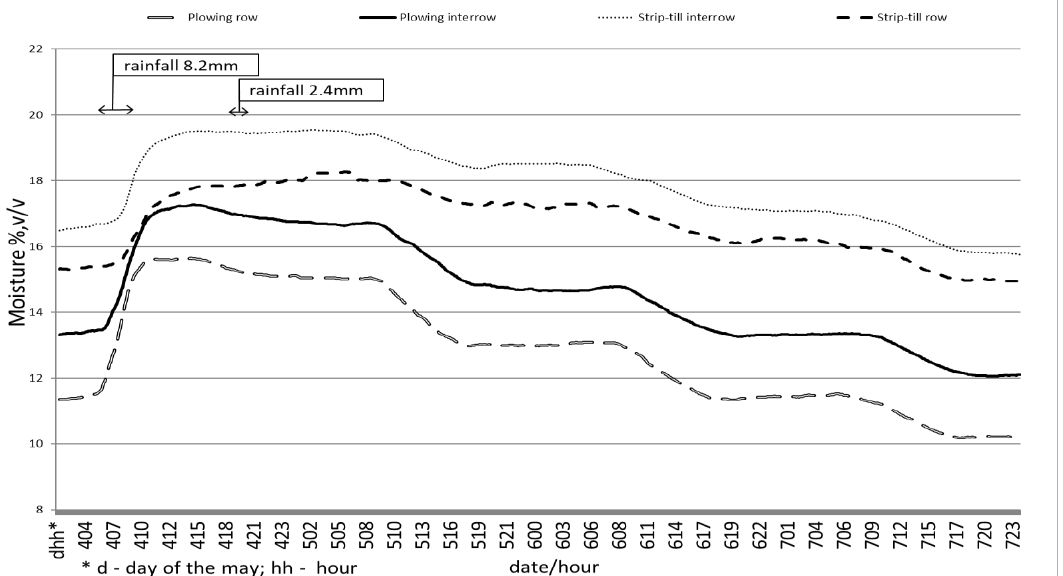
Figure 3. Dynamics of soil moisture in the row of barley plants and in the inter-row for ST and PT in the period 4 – 7 May.